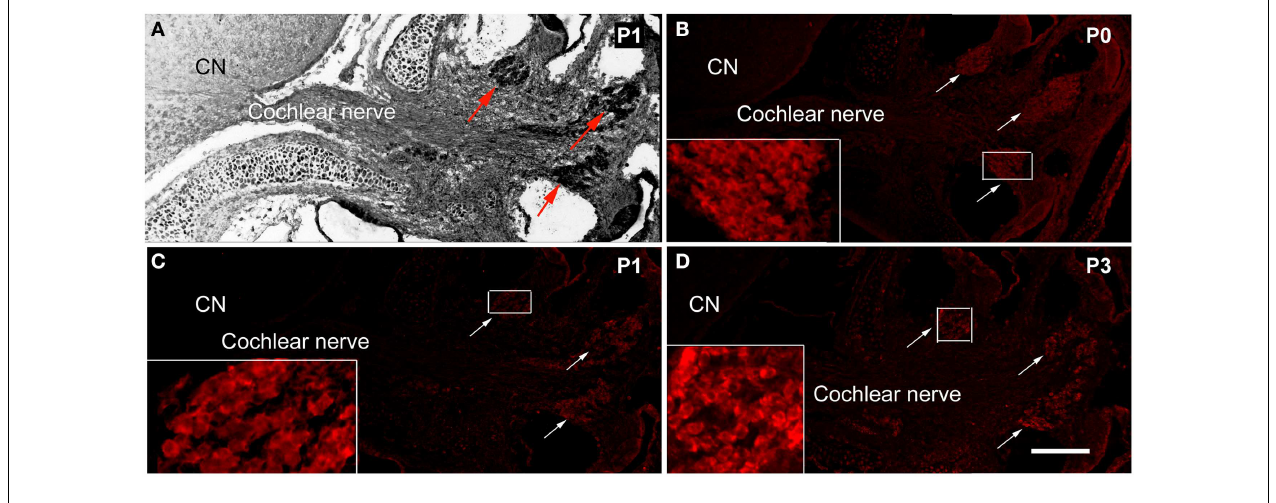
cochlear nerve distal to the PCTZ, which was determined by immunostaining of MPZ [red, arrows in (B–D) ], was found around the soma of the spiral ganglion neurons in P0 (B) , P1 (C) , and P3 (D) mice. Scale: 50 µ m shown in (D)